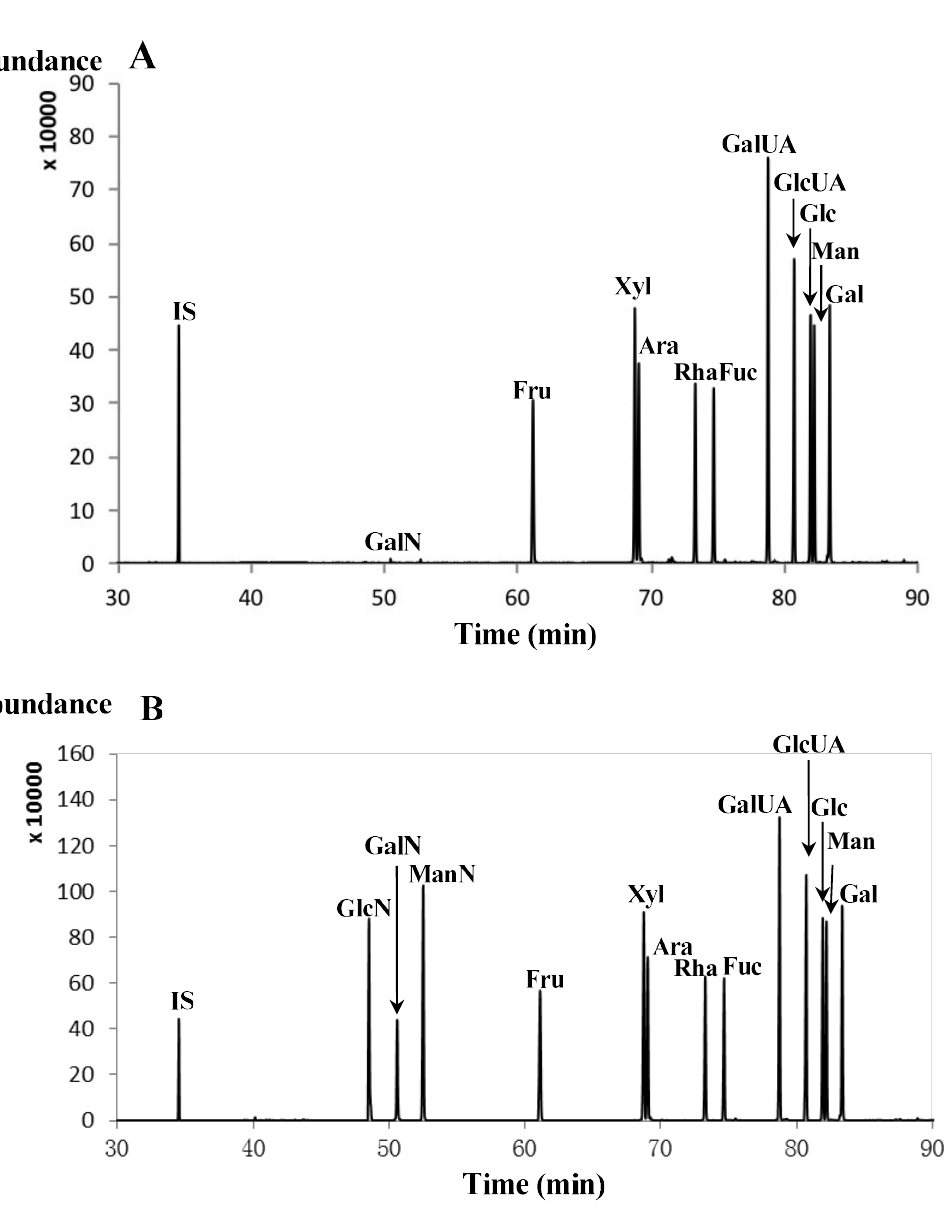
Figure 2. GC-MS chromatograms of TMSD derivatives of monosaccharide standards without and with chloroform liquid-liquid extractions to give ( A ) and ( B ), respectively. The sample concentration was 3/5 of the mixed reference stock solution, as shown in section 2.6.